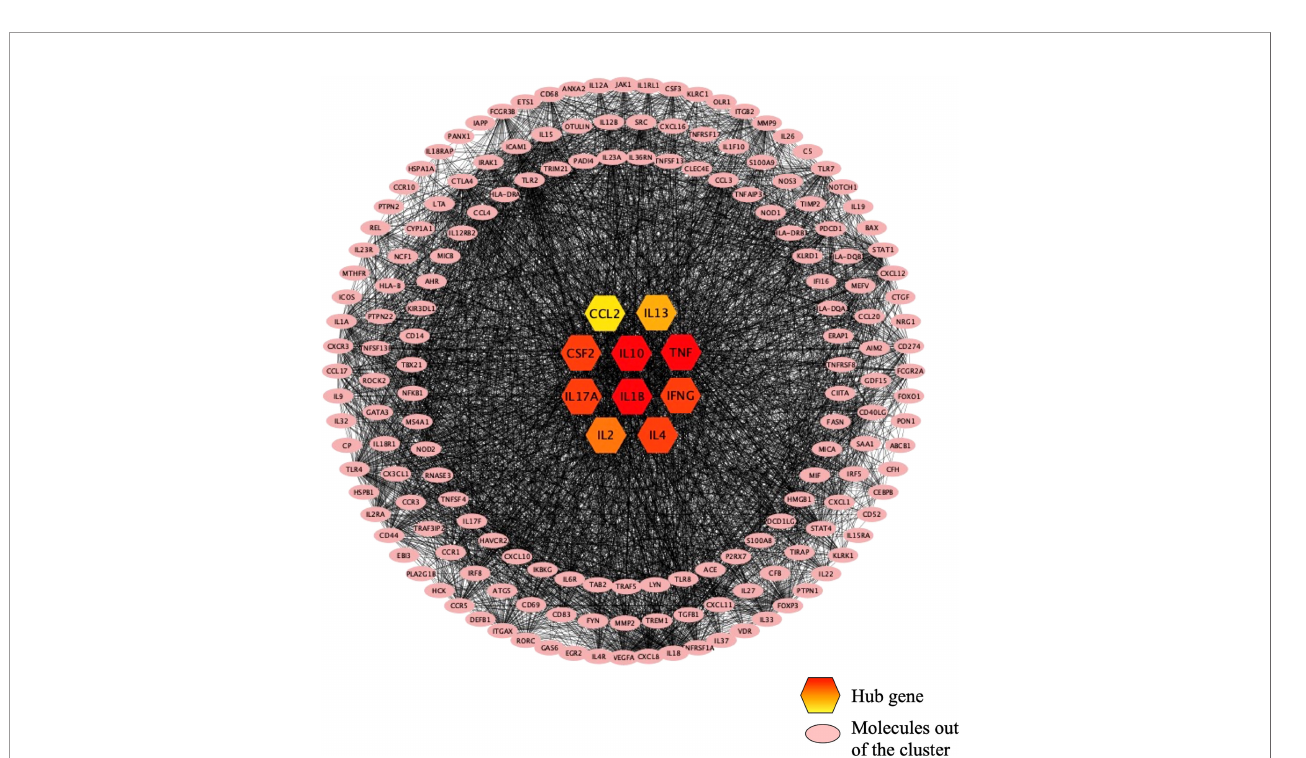
FIGURE 5 | The top 10 hub genes recognized in the PPI network. The top 10 hub genes are in the center of the fi gure, and the color from red to yellow indicates the difference from large to small. TNF, IL1B, and IL10 are the top 3 hub genes. Molecules in pink are not in any cluster.